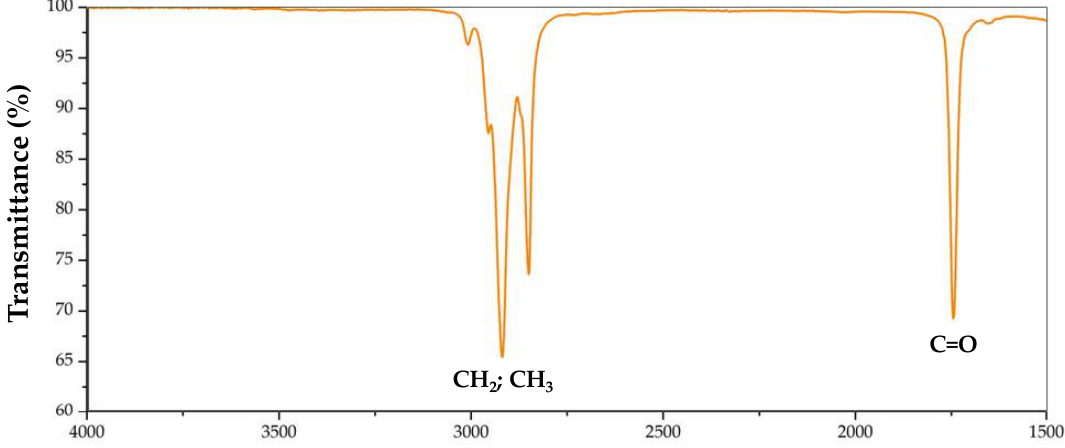
Figure 1. FTIR – ATR spectrum of soil. Figure 1. FTIR–ATR spectrum of soil.